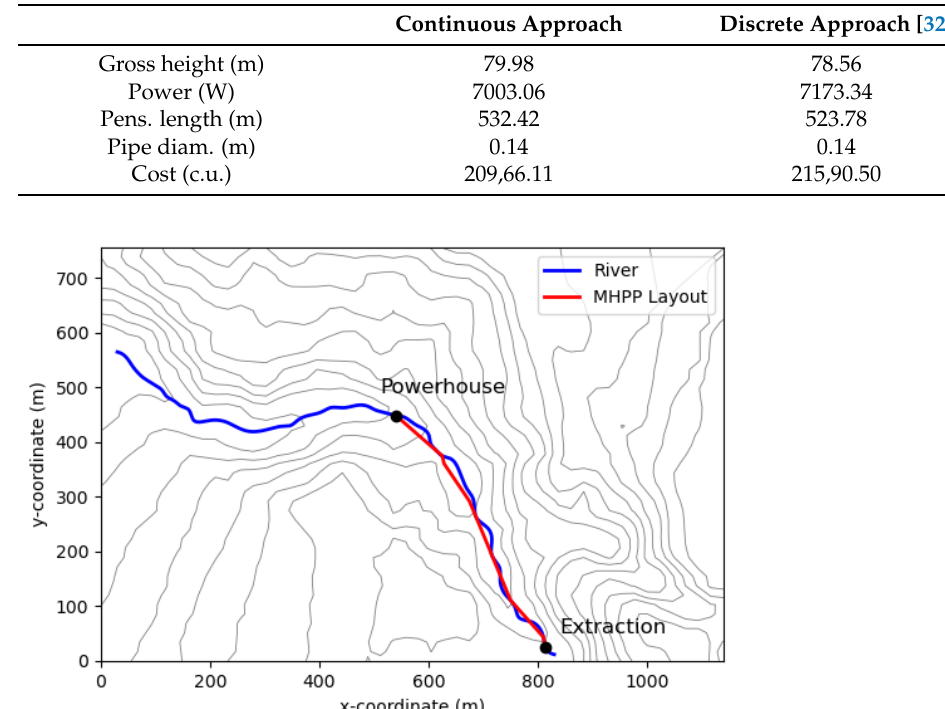
Table 5. Comparison between the current (continuous) and the previous (discrete) approach.